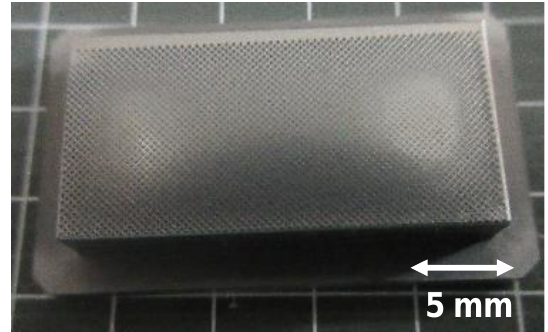
Figure 6. Selectively plasma-nitrided AISI316 die substrate at 673 K for 14.4 ks. Scanning electric microscopy as well as EDX were utilized to analyze the microstructure of the nitrided AISI316 die surface and to map nitrogen across the square cell units. As shown in Figure 7a, the micro-meshed lines were regularly aligned by the pitch of 250 μ m. These lines also had higher nitrogen content than 5 mass% selectively in their widths, as analyzed in Figure 7b. Although the residuals of masking inks were left as a thin film, no height difference was seen between the masked and nitrided areas on the surface.